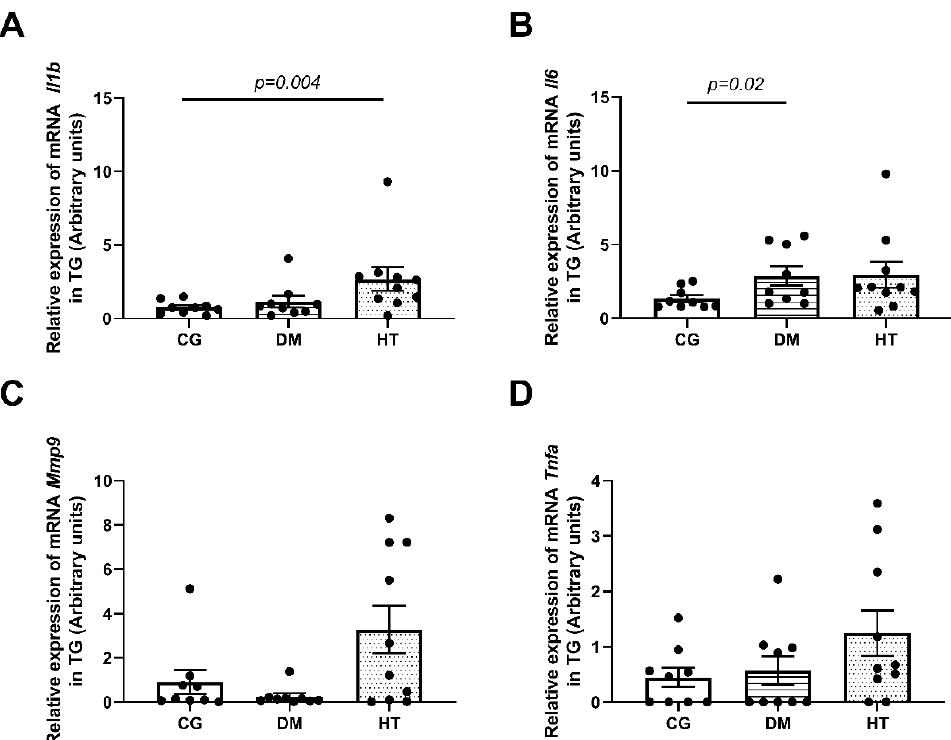
Figure 4. Relative mRNA expression of pro-inflammatory cytokines in the TG. The data revealed a higher expression of Il1b mRNA in HT group ( p = 0.004) ( A ) and a higher expression of Il6 mRNA in DM group ( p = 0.02) ( B ). The expression of Mmp9 and Tnfa mRNA was not different in the groups ( C , D ). In all tests, n = 10/animals per group. The comparisons were made using the Mann–Whitney U test. Each animal value is represented by a black dot in the figure.